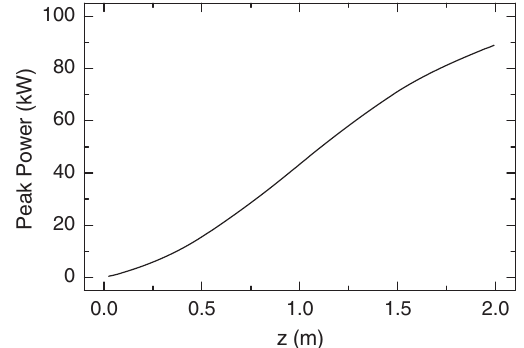
FIG. 6. Growth of the peak power at the